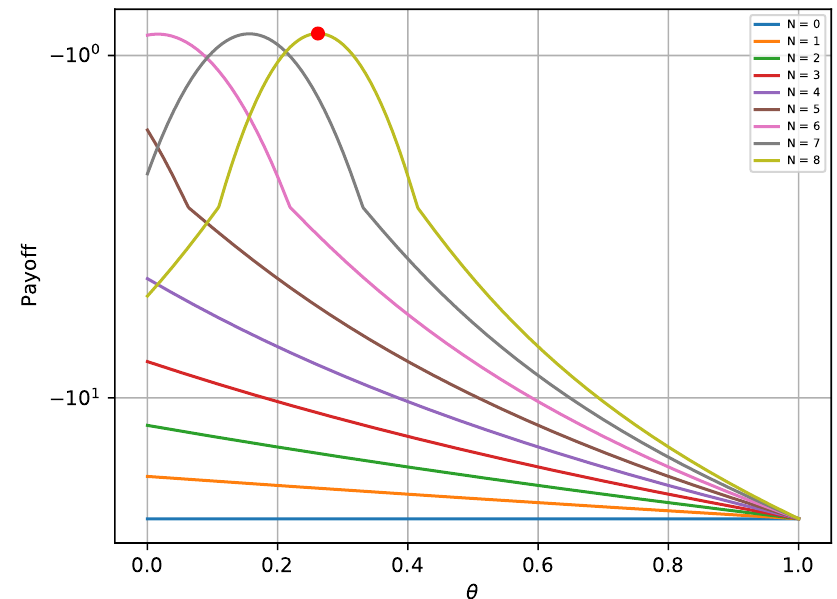
Figure 6. Players’ payoff for different strategies in a single turn of the repeated game.